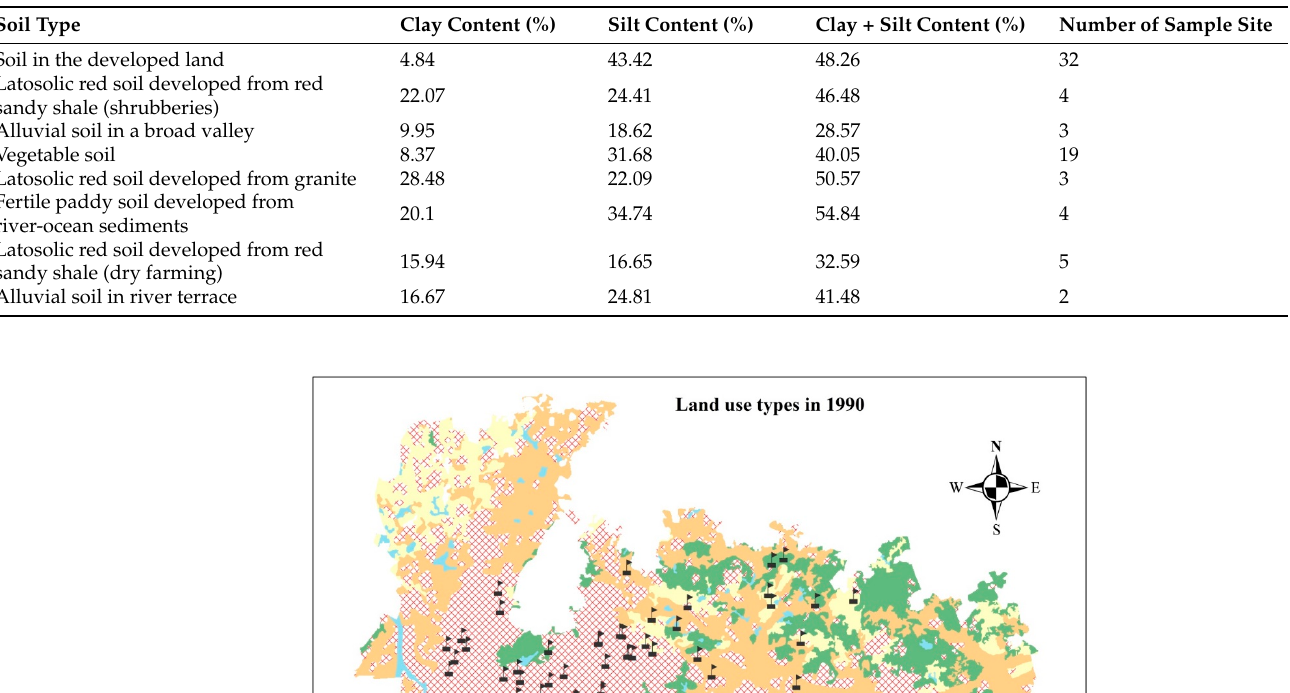
images (30 m resolution), 54% of the sample plots had already been developed in 1990 (39 samples) and farmland accounted for 28% (Figure 3). Table 2. Soil clay and silt content of different soil types in the study site in 1985.